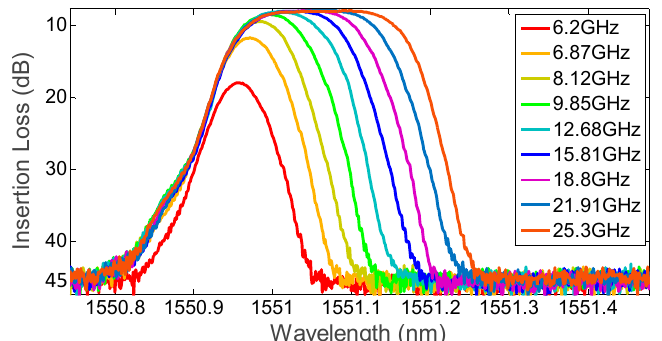
Figure 6. Flexible bandwidth adjustment with a minimum 3-dB bandwidth of 6.2 GHz to 25.3